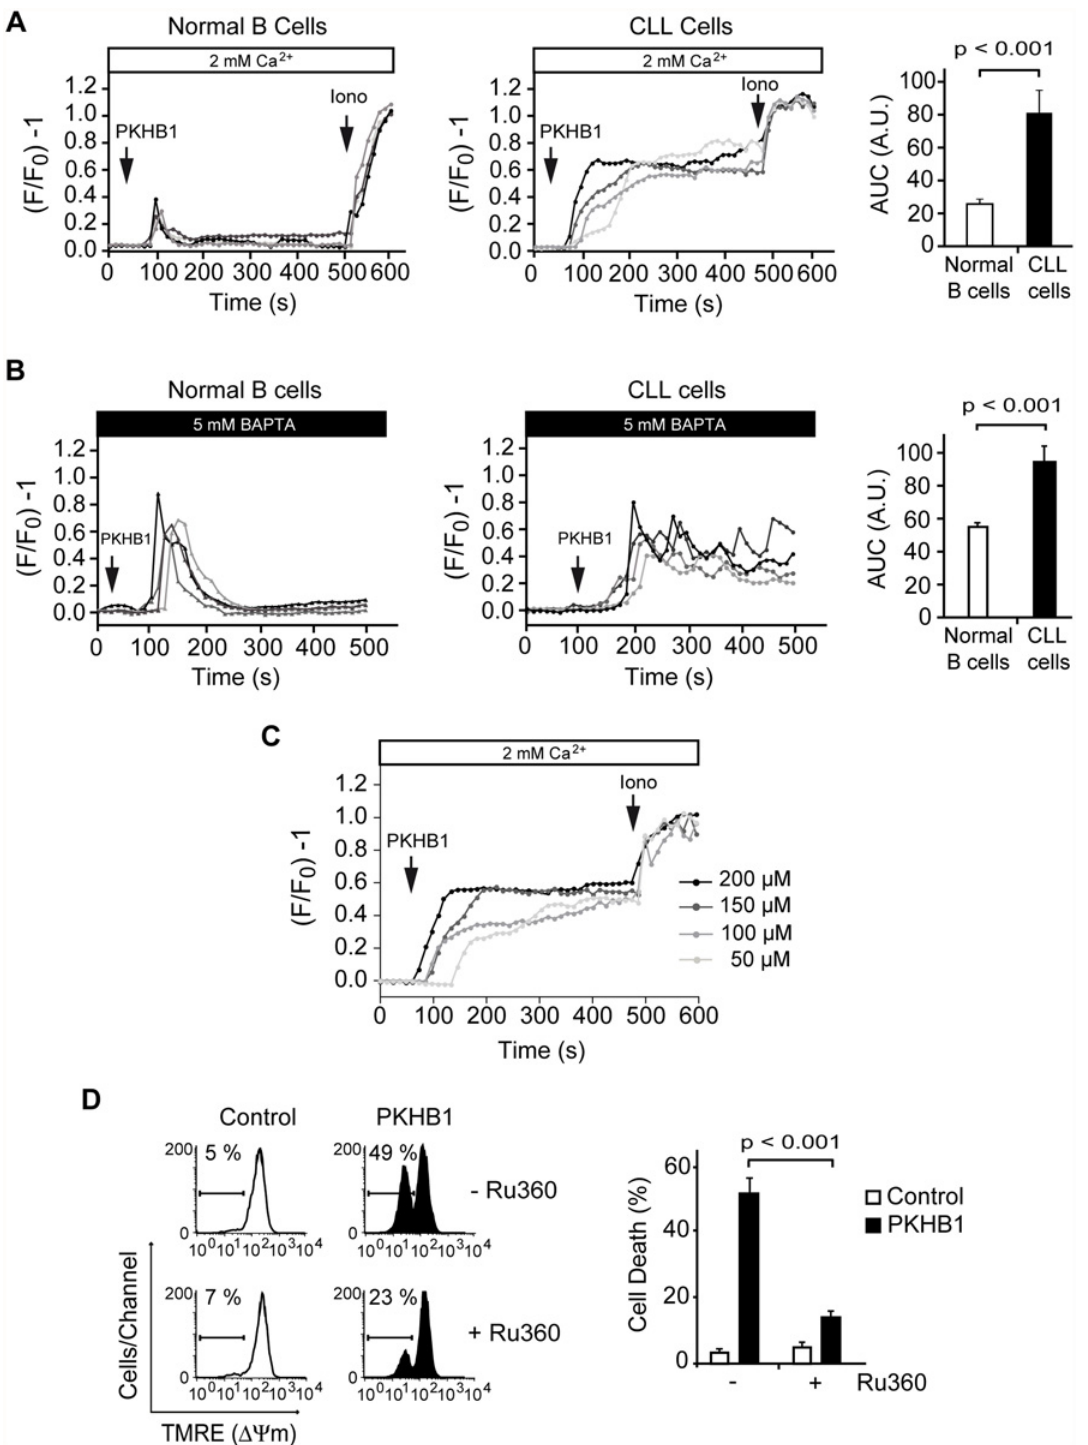
Fig 4. PKHB1 treatment results in sustained Ca 2+ mobilization that induces mitochondrial damage and PCD in CLL cells. (A) Representative Ca 2+ mobilization recorded in 200- μ M PKHB1-treated normal (left) and CLL (right) B cells ( n = 4 each). Ionomycin (Iono, 1 μ M) was utilized as a control to show the maximum response. The histograms show mean ± SD of the area under the curve (AUC) (in arbitrary units [A.U.]) ( n = 12). (B) Representative Ca 2+ release from internal stores was visualized in PKHB1-treated normal (left) and CLL (right) B cells ( n = 4 each) in Ca 2+ -free medium (plus 5 mM BAPTA). Histograms represent mean ± SD of the area under the curve ( n = 13). (C) Representative Ca 2+ mobilization curves were recorded in CLL cells after treatment with